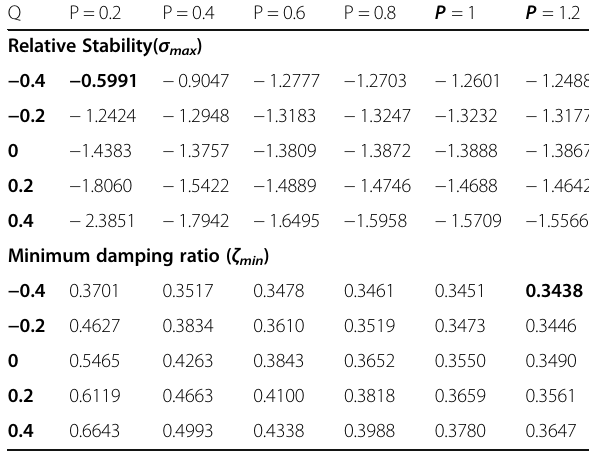
Table 1 Relative stability and minimum damping ratio for x e = 0.4 Ω with P and Q in